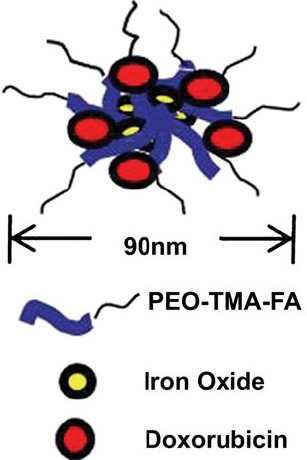
Figure 11. Structure of DDS based on PEO-TMA-FA, Iron Oxide and DOX (Reprinted with permis- sion from Ref. [76]. 2010, Jin Hee).